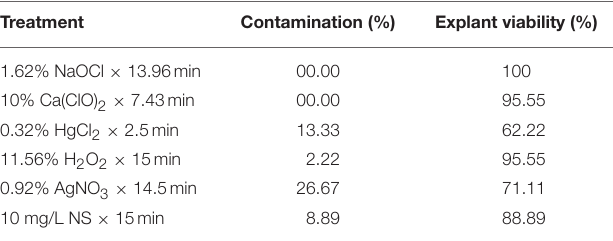
TABLE 10 | Validation of the predicted data for contamination frequency (EF) and explant viability of chrysanthemum in validation experiment. Treatment Contamination